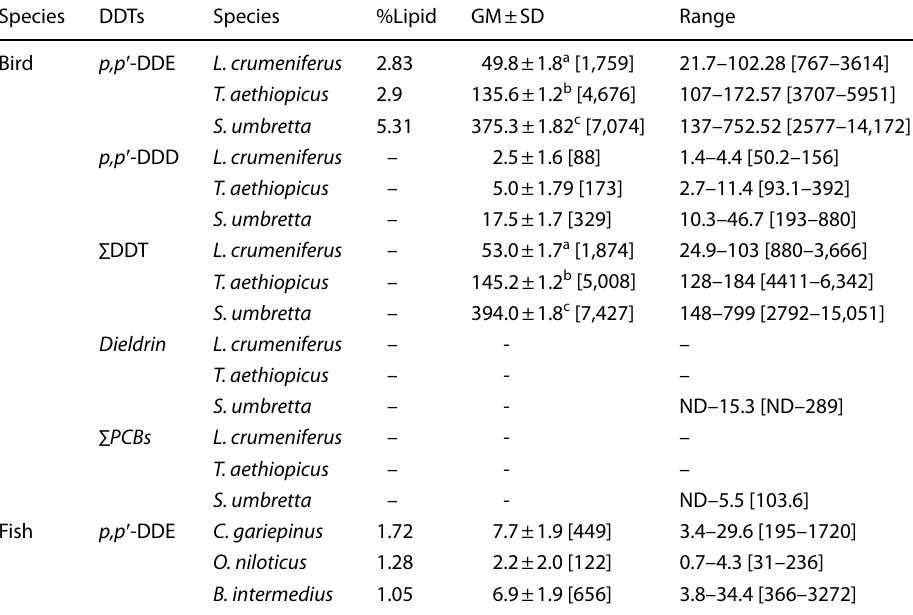
Geometric mean values with different superscripted letters are significantly different (p